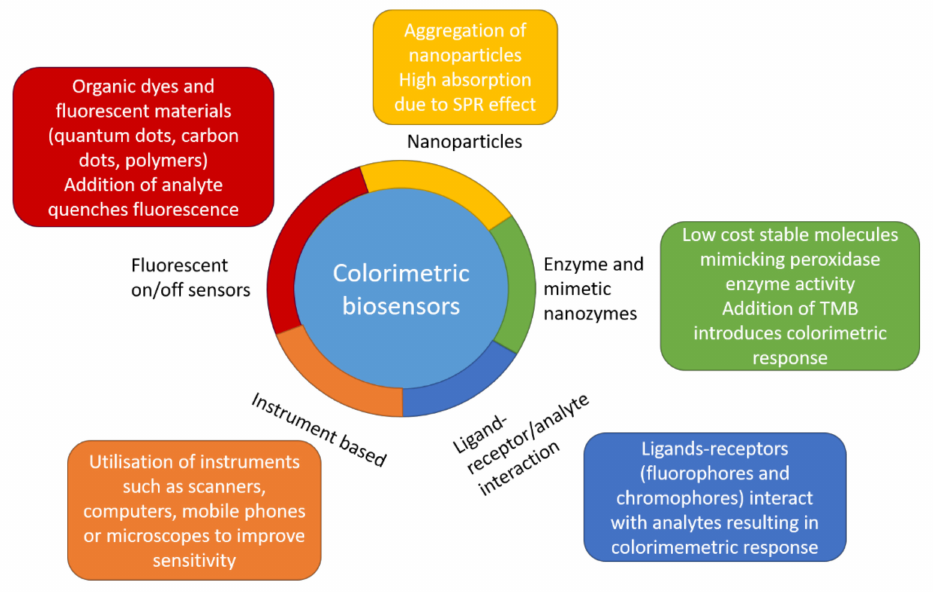
Figure 8. Summary of different approaches to colorimetric biosensors and brief explanation of their